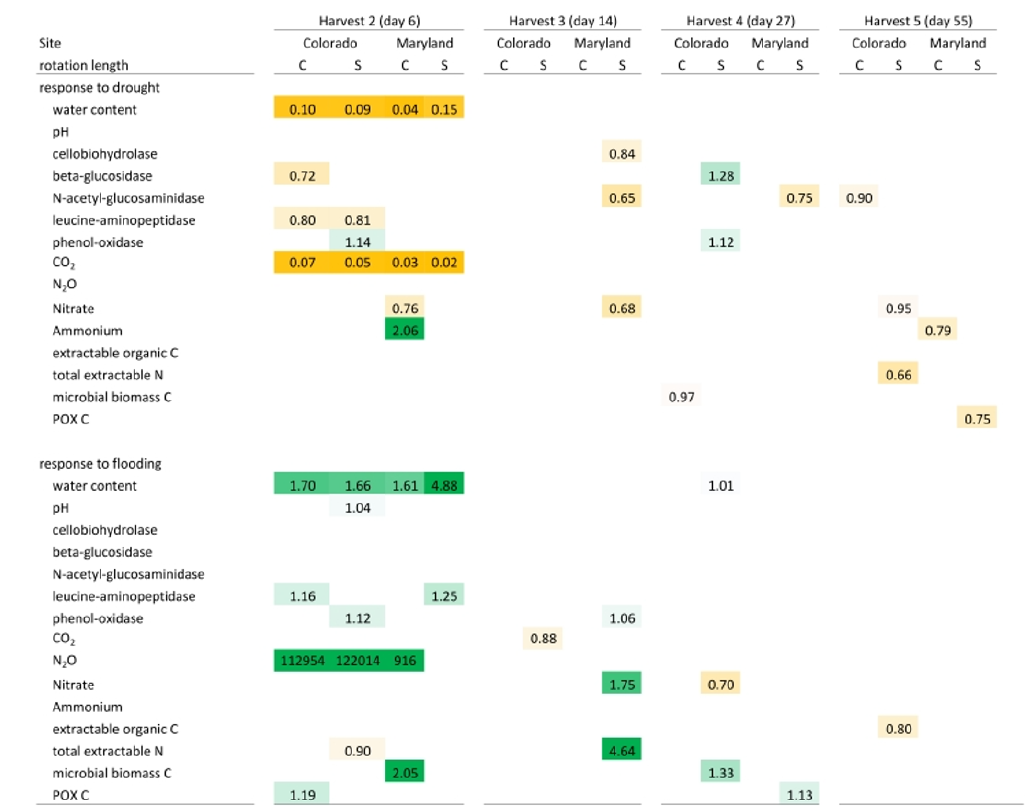
Table 3. Mean response ratios of soil carbon and nitrogen pools, microbial enzyme activities, and CO 2 and N 2 O production in response to drought and flooding during (day 6), immediately after (day 14), 2 weeks (day 27) after, and 6 weeks (day 55) after the first stress cycle. Orange colors indicate a reduction relative to the control and green colors represent an increase. Only significant differences ( p < 0 . 05) are shown. Response ratios are calculated as the value for a given treatment divided by the value of the respective control at 50%WHC. C is